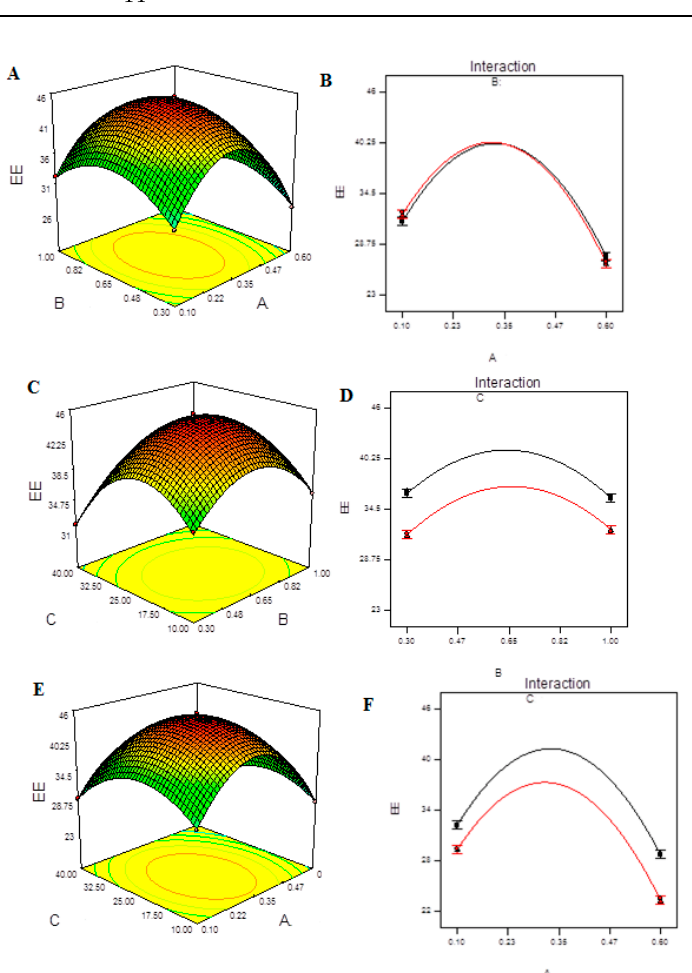
Figure 5. Model graphs: EE. ( A ) Three-dimensional response surfaces plots showing the effect of variables (A: TPP concentration and B: CS concentration) on response (EE), ( B ) interaction plot, ( C ) 3D response surfaces plots showing the effect of variables (B: CS concentration and C: ultrasonication energy) on response (EE). ( D ) interaction plot, ( E ) 3D response surfaces plots showing the effect of variables (A: TPP concentration and C: ultrasonication energy) on response (EE) and ( F ) interaction plot.